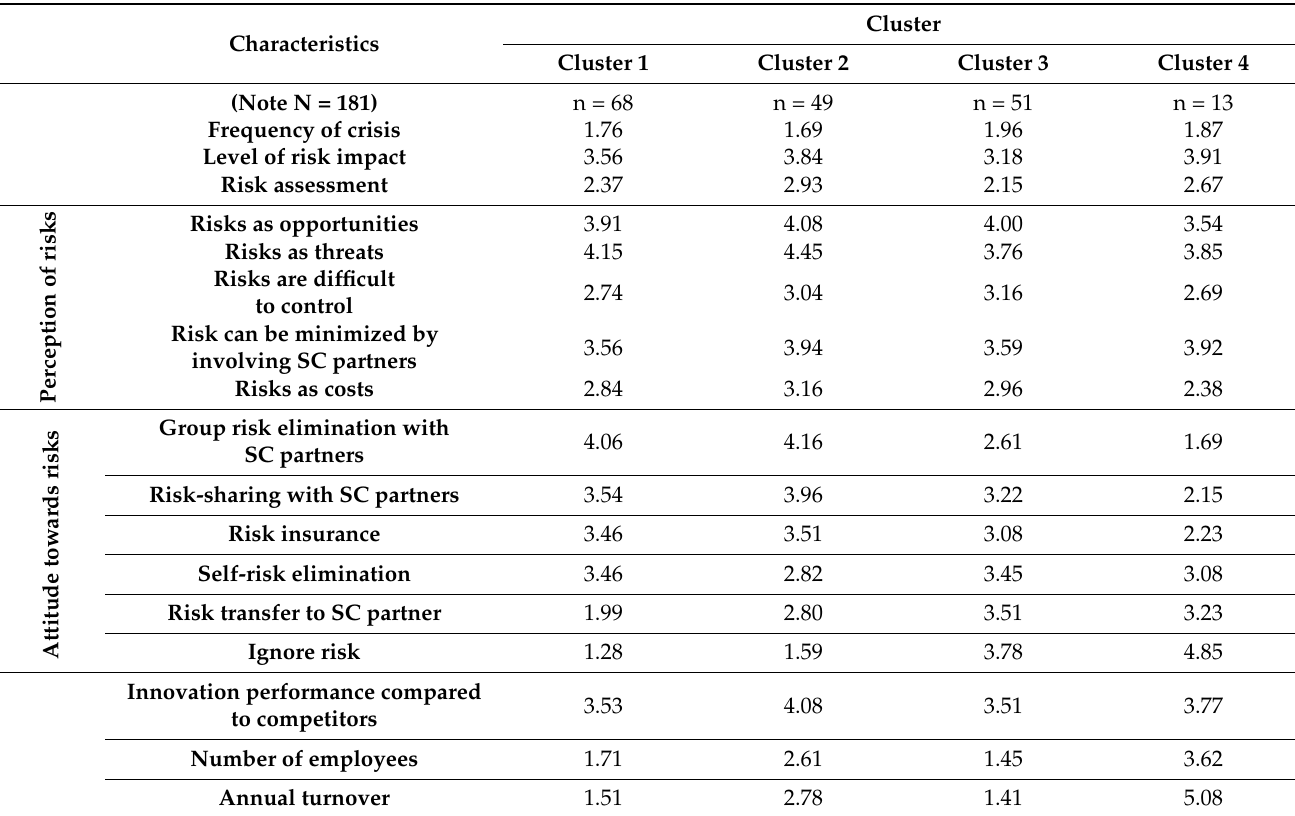
Table 4. Result of the cluster